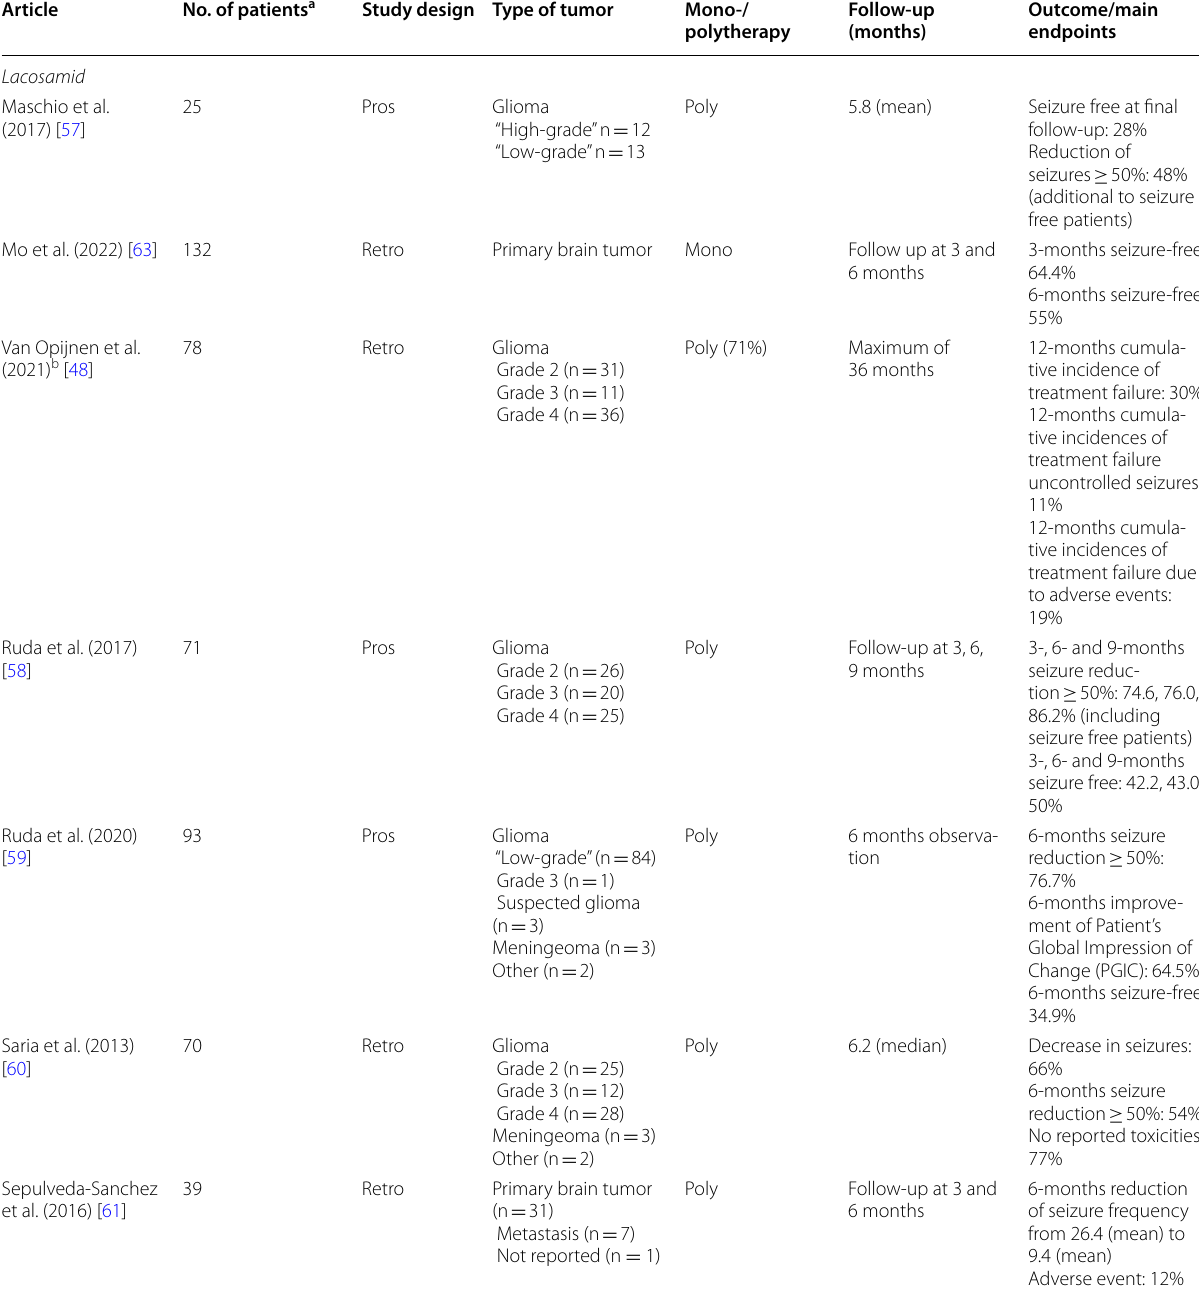
Table 1 Overview of studies on lacosamide, lamotrigine, levetiracetam, topiramate and valproic acid in brain tumor related epilepsy (studies that included 25 patients on adults with 3 months observation ≥ ≥